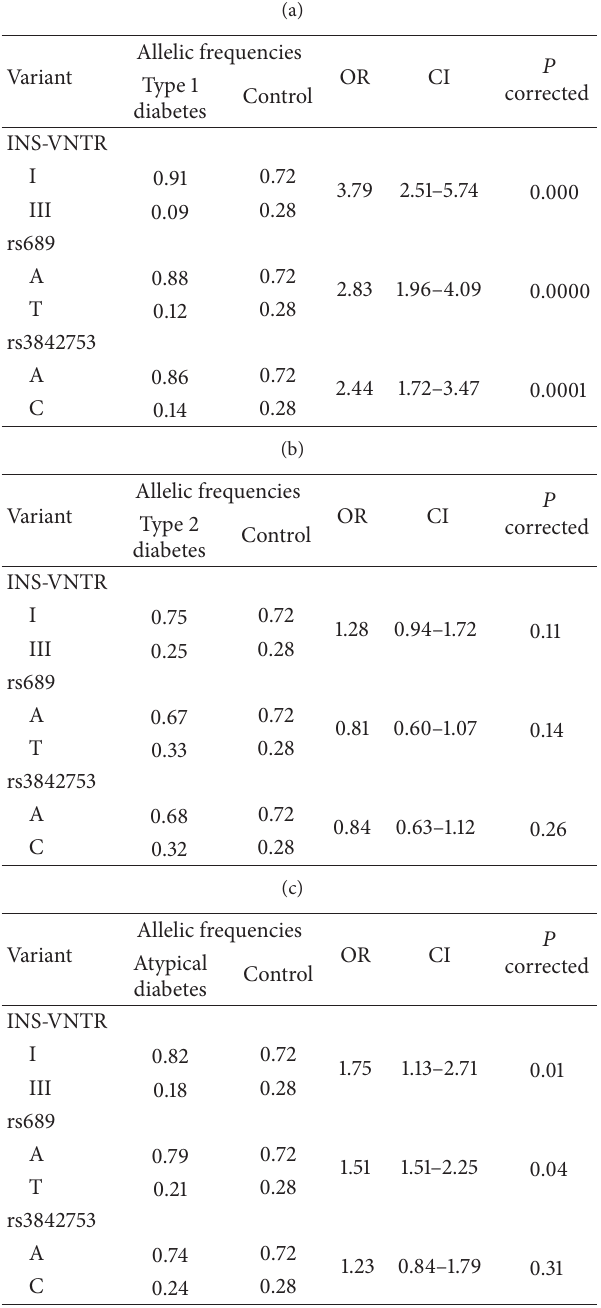
Table 2: Allelic frequencies of the SNPs: (a) type 1 diabetes, (b) type 2 diabetes, and (c) atypical diabetes.